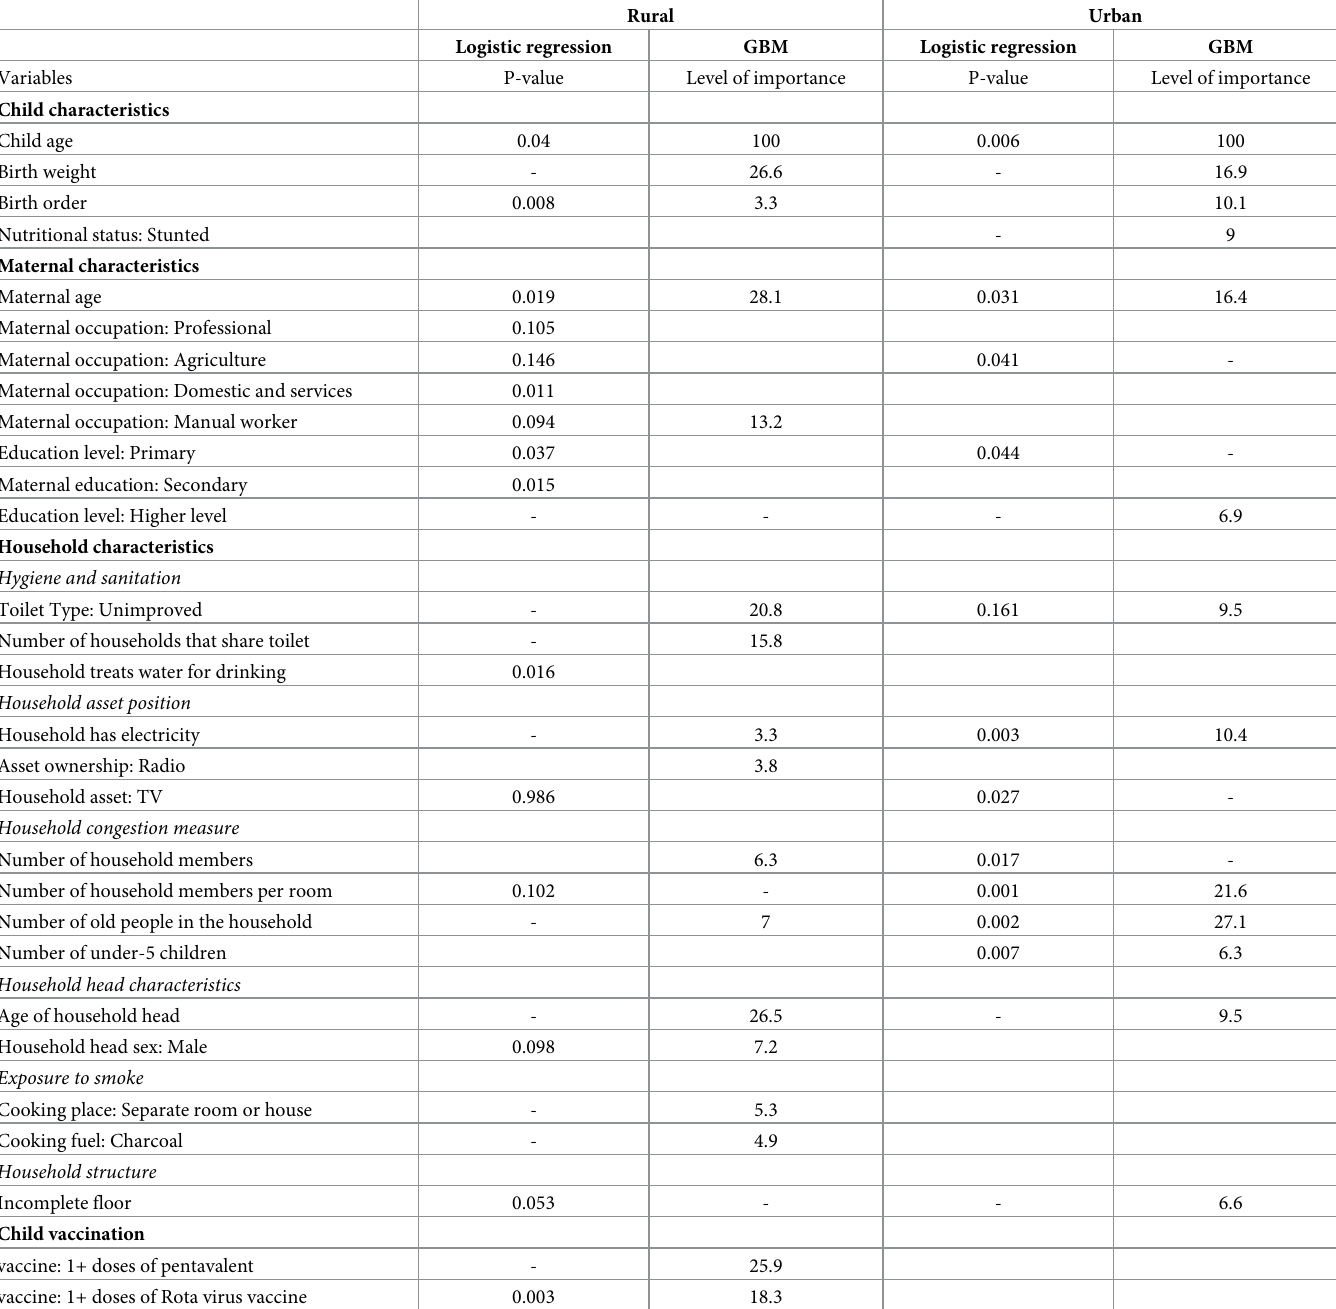
Table 4. Differences in identified predictors of diarrhoea in traditional logistic regression and